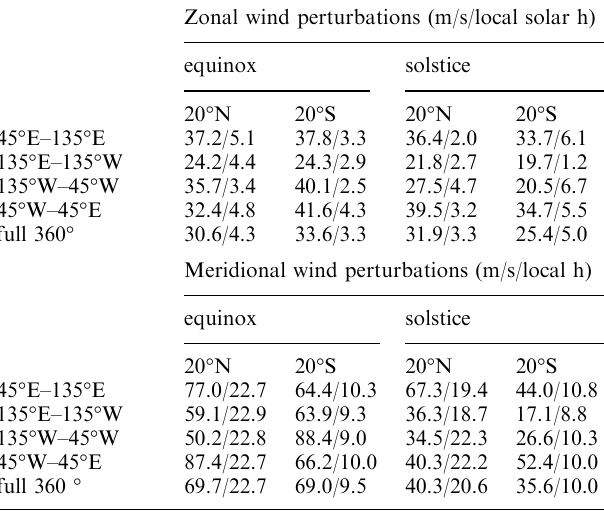
Table 1. Nonmigrating signatures of the diurnal tide at 96 km observed by WINDII Zonal wind perturbations (m/s/local solar h) equinox solstice